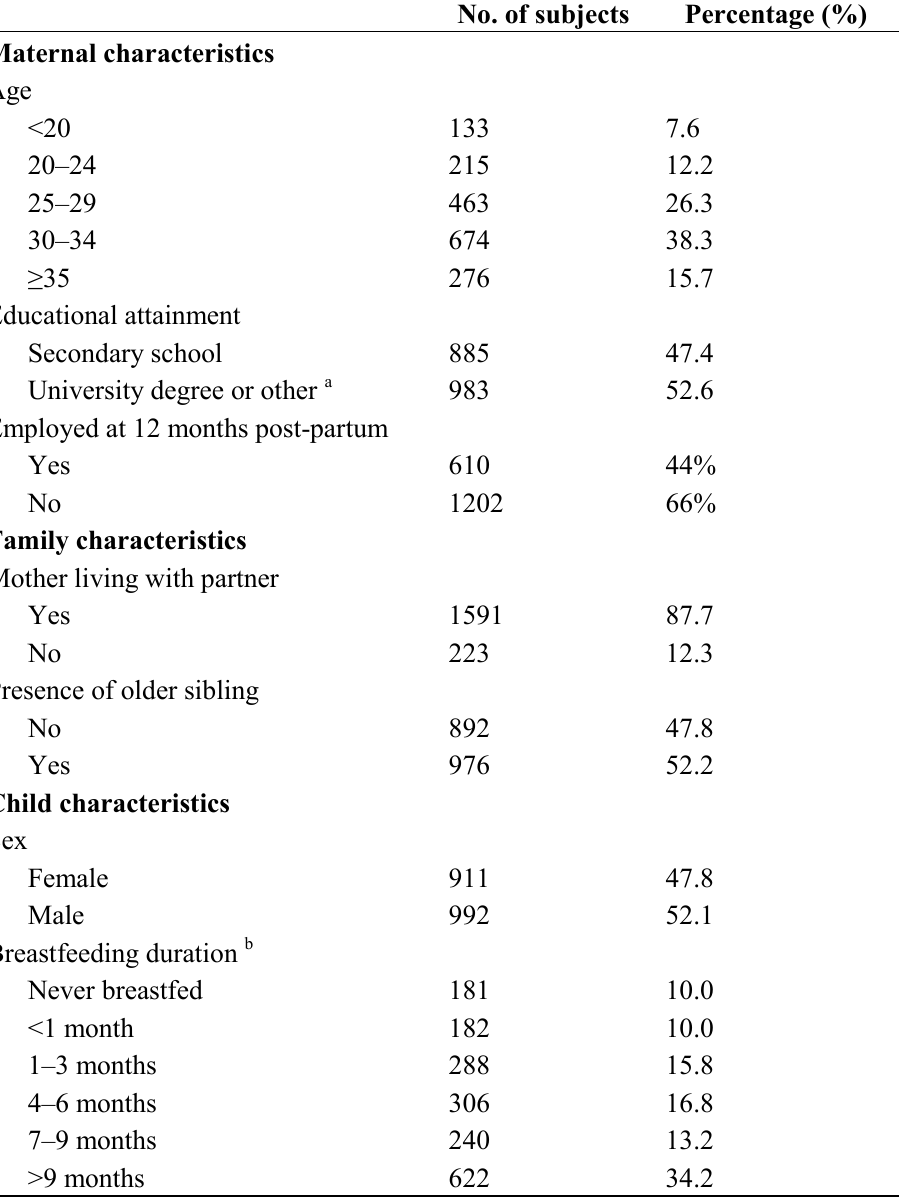
Table 2. Maternal, child and family characteristics of